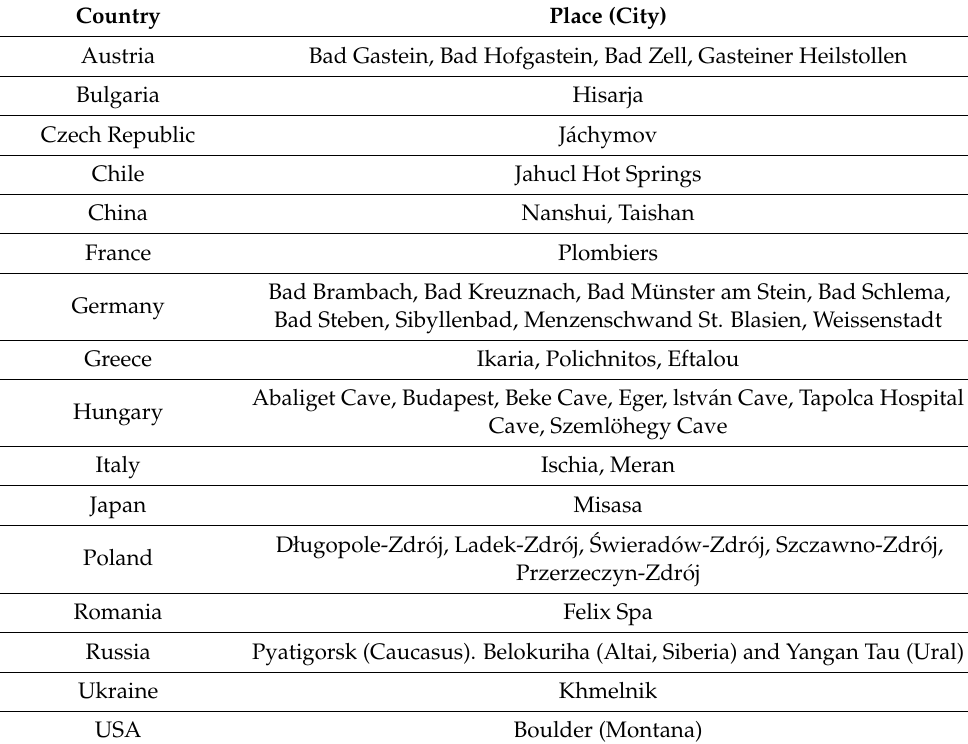
Table A1. Some of today’s radon spas all over the World